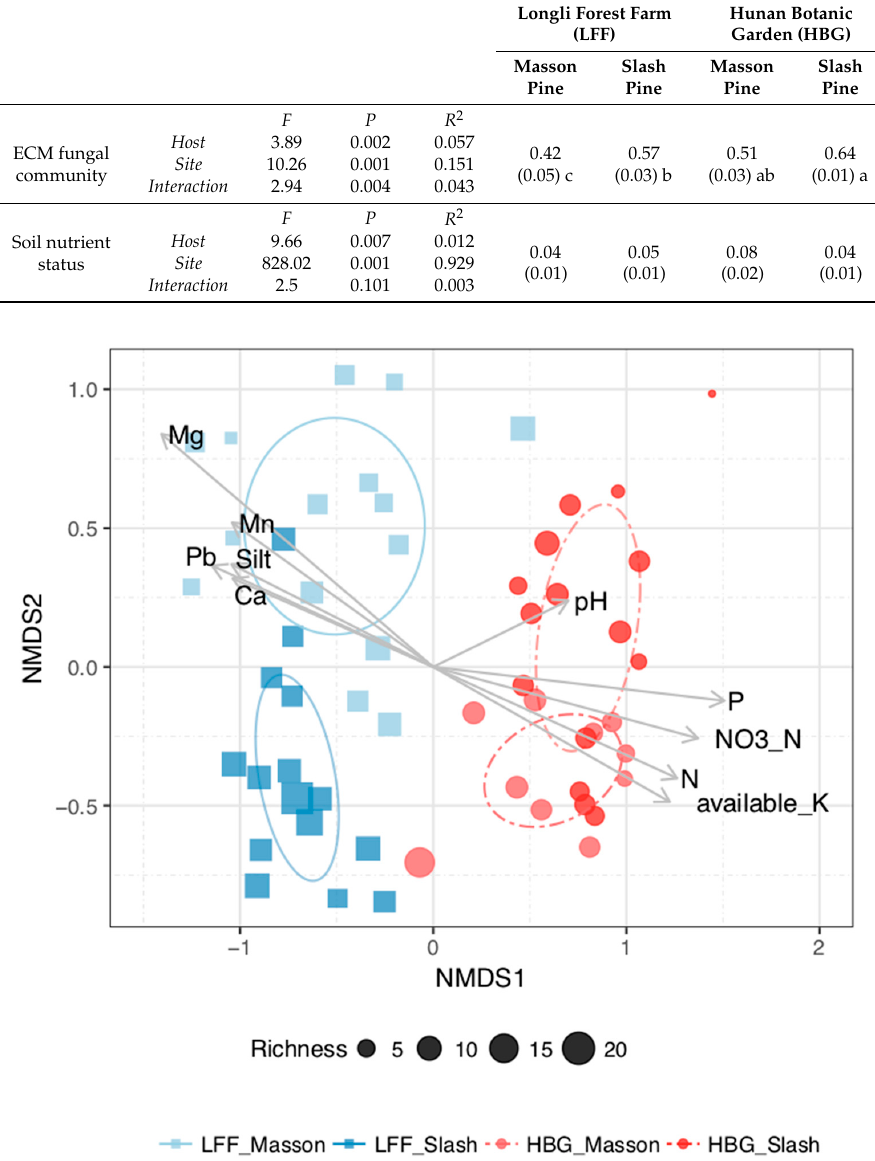
Figure 4. Non-metric multidimensional scaling (NMDS) of ectomycorrhizal fungal community composition. Point size reflects the richness of each sample. Significant abiotic variables ( p < 0.05) were fitted as vectors onto the NMDS graph. LFF—Longli Forest Farm; HBG—Hunan Botanic Garden. Table 3. PERMANOVA analyses performed to test the differences in ECM fungal community and soil properties among forest types. Post hoc PERMDISP pair-wise analysis tests were applied to data from all forest types across the sites. Values represent the site mean with standard error in parentheses. Different letters indicate significant differences among forest types based on Tukey HSD post-hoc test ( p < 0.05).